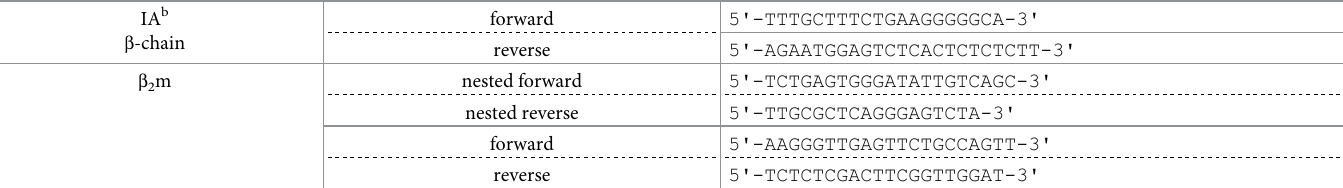
S2 Table. Primers used to for mutation analysis at genomic target